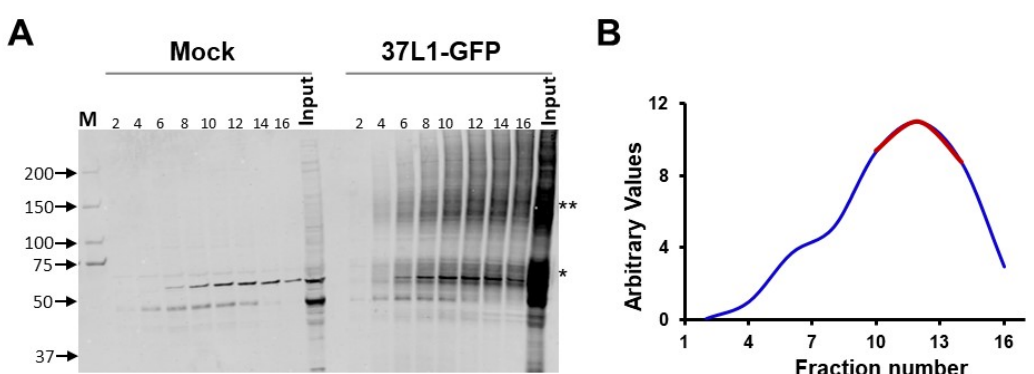
Figure 1. Glycerol gradient fraction of GPR37L1 protein complex. Protein preparations from mock- or GPR37L1-GFP-transfected hRPTCs were subjected to glycerol gradient (10–30%) centrifugation. ( A ) Fractions collected from the top of the gradient were subjected to immunoblotting for GPR37L1-GFP. Positions of the molecular size markers are indicated on the left. Positions of GPR37L1-GFP * monomer and ** high molecular aggregate are indicated on the right. ( B ) Graph showing the densitometric quantification of GPR37L1-GFP in the glycerol gradient fractions (blue). Fractions 10–14 (red) containing the highest levels of GPR37L1-GFP were pooled and used for co-immunoprecipitation (Co-IP), followed by mass spectrometry analyses.